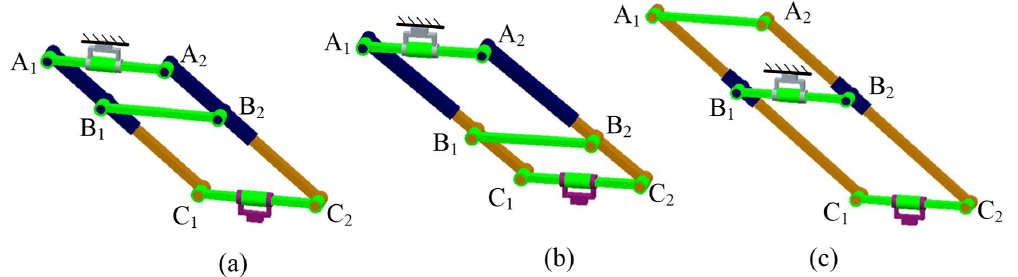
Figure 3. Three equivalent PLMEs limbs: (a) mid-link connecting outer tubes, (b) mid-link connecting inner tubes, (c) mid-link fixing on the ground.